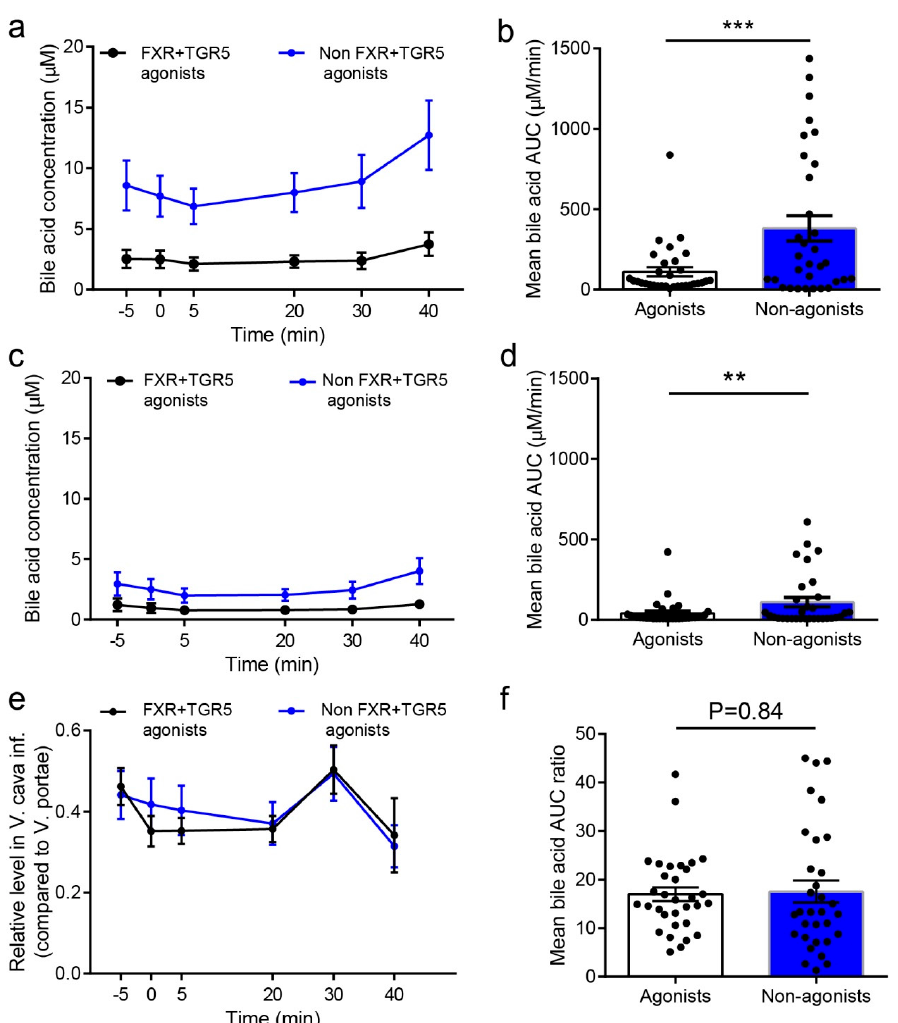
Figure 2. FXR and TRG5 activating bile acids and non-activating bile acids. Levels of bile acids that respectively are agonist and non-agonists for FXR and TGR5 are shown. Following BAs were, based on previous studies on FXR activation and TGR5 activation [22–26], categorized as FXR and TGR5 agonists: Deoxycholic acid, Chenodeoxycholic acid, Lithocholic acid (both unconjugated and glycine- and taurine-conjugated isoforms). Cholic acid and Ursodeoxycholic acid were classified as non-agonists based on same studies. Murine specific BAs were not included in the analysis because of lack of information with regards to agonistic / non-agonistic functions on FXR and TGR5. ( a , b ): Mean concentration of FXR / TGR5 agonists and non-agonists at individual time points (mean ± SEM, µ M) ( µ M) in vena portae (a), vena cava inferior (c). ( c , d ): AUC values ( − 5 to 40 min) of FXR / TGR5 agonists and non-agonists (mean values ± SEM) in vena portae (b) and vena cava inferior (d). Individual values are indicated with dots. ( e ): Relative level (mean ± SEM) of FXR / TGR5 agonist and non-agonists (conc. vena cava inferior / conc. Vena portae). ( f ): Mean bile acid AUC ratio ( − 5 to 40 min) of FXR / TGR5 agonist and non-agonists (conc. vena cava inferior / conc. Vena portae) ( e ). Individual values are indicated with dots. FXR / TGR5 agonist was defined as chenodeoxycholic acid, taurodeoxycholic acid, deoxycholic acid, and taurodeoxycholic acid, whereas non-agonist was cholic acid, taurocholic acid, ursocholic acid, and tauroursocholic acid. Murine-specific BAs (MCA alpha, MCA beta, and taurine-conjugated forms of these) were not included in the analysis because of lack of information regarding FXR and TGR5 activation. Statistical significance was tested by paired student t -test, ** p < 0.01, *** p < 0.001, n =